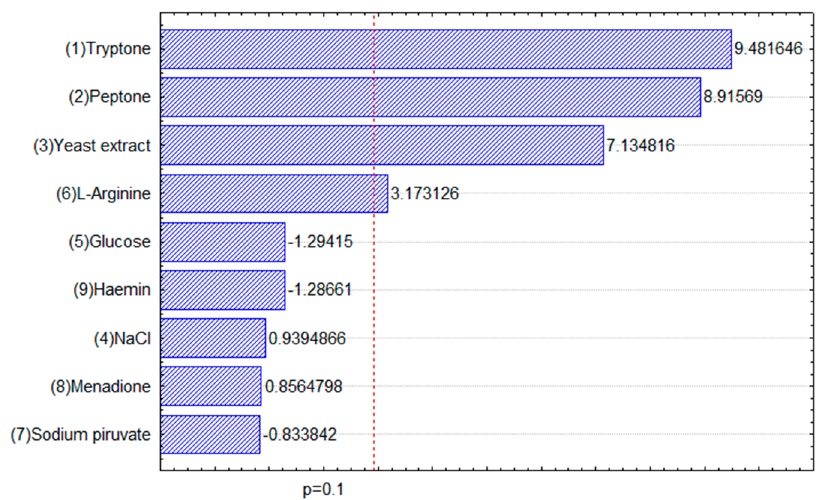
Table 2. Placket–Burman design matrix with real and coded values for C. carboxidivorans syngas fermentation with 1 g/L glucose. Response variables: biomass concentration—[X 24 ] (g d.w.cells/L)— and maximum ethanol production—P EtOH (g/L).